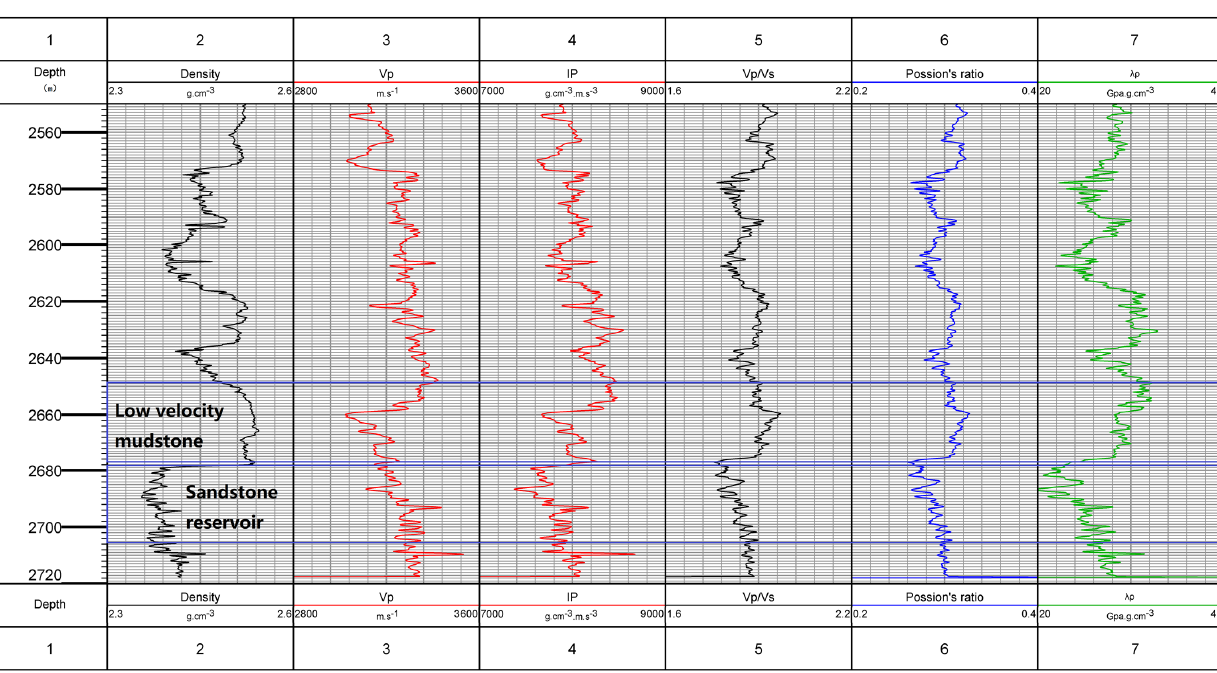
Figure 15. Logging curve of well DF1-X12.